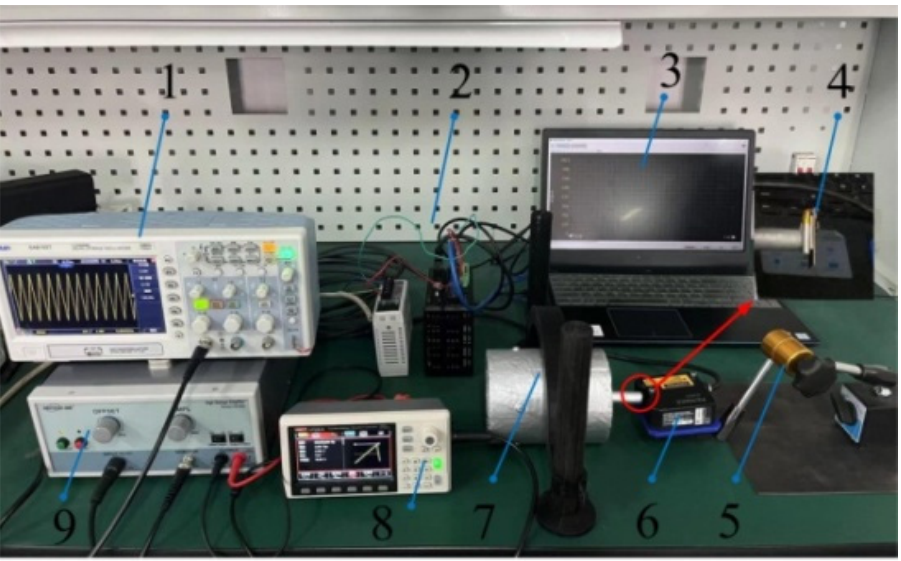
Figure 22. The experimental platform (1. Oscilloscope, 2. Controller, 3. PC, 4. Attitude Sensor 5. Magnetic Base, 6. Laser Sensor, 7. Prototype, 8. Signal Generator, 9. Voltage Amplifier).